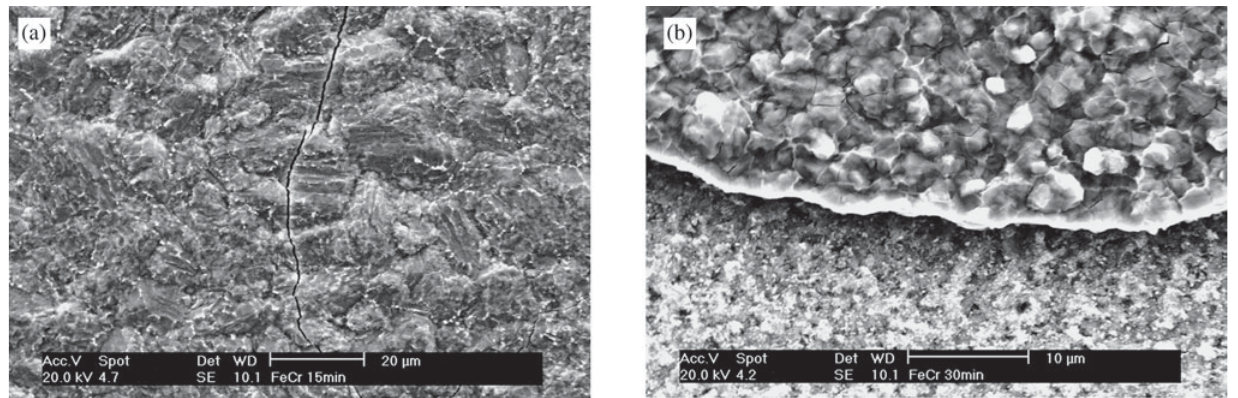
Figure 8. Surface of the FeCr alloy sulfidized at 700 °C. a) for 15 min and b) for 30 min.